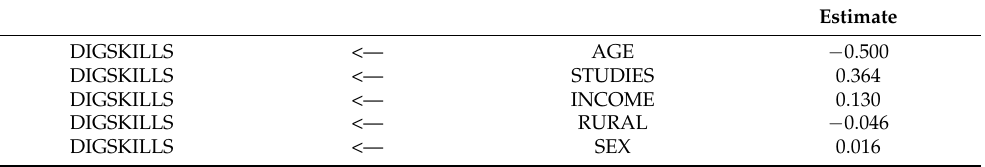
Table A8. Standardized Regression Weights: (Group number 1-Default model).